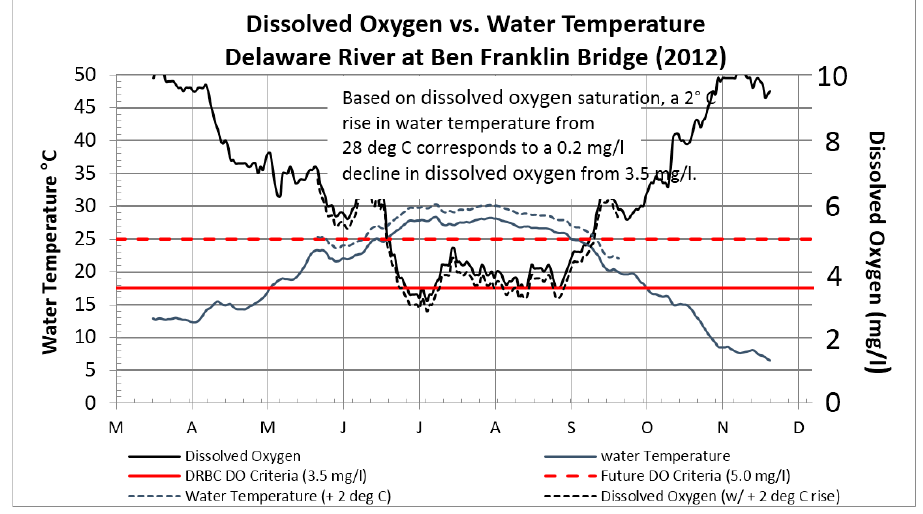
Figure 16. Dissolved oxygen/water temperature along the Delaware River at Ben Franklin Bridge.